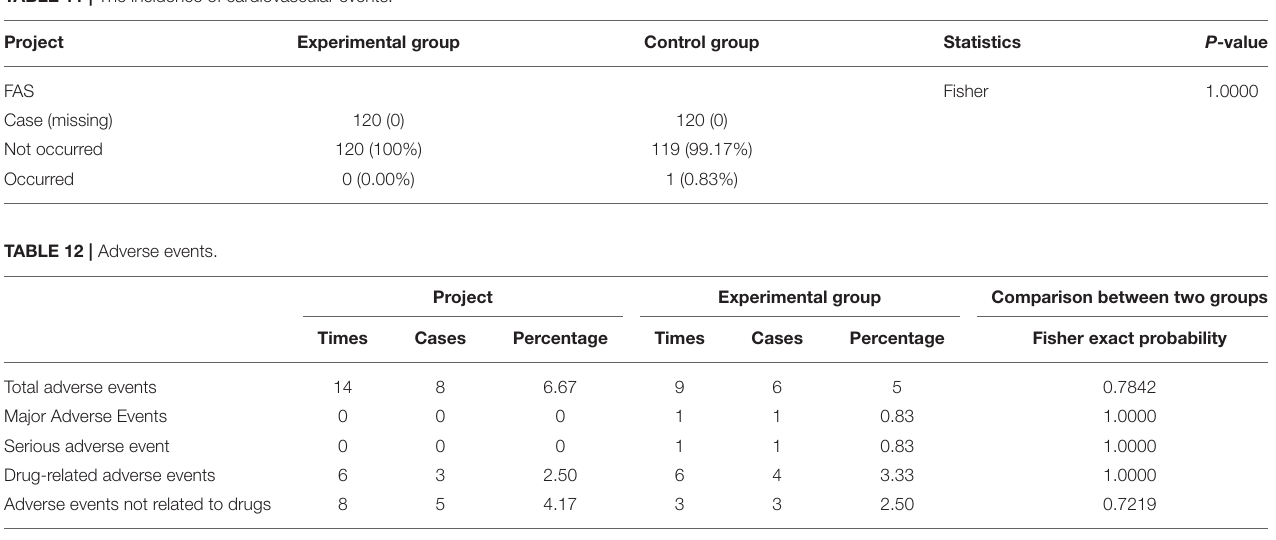
TABLE 11 | The incidence of cardiovascular events.